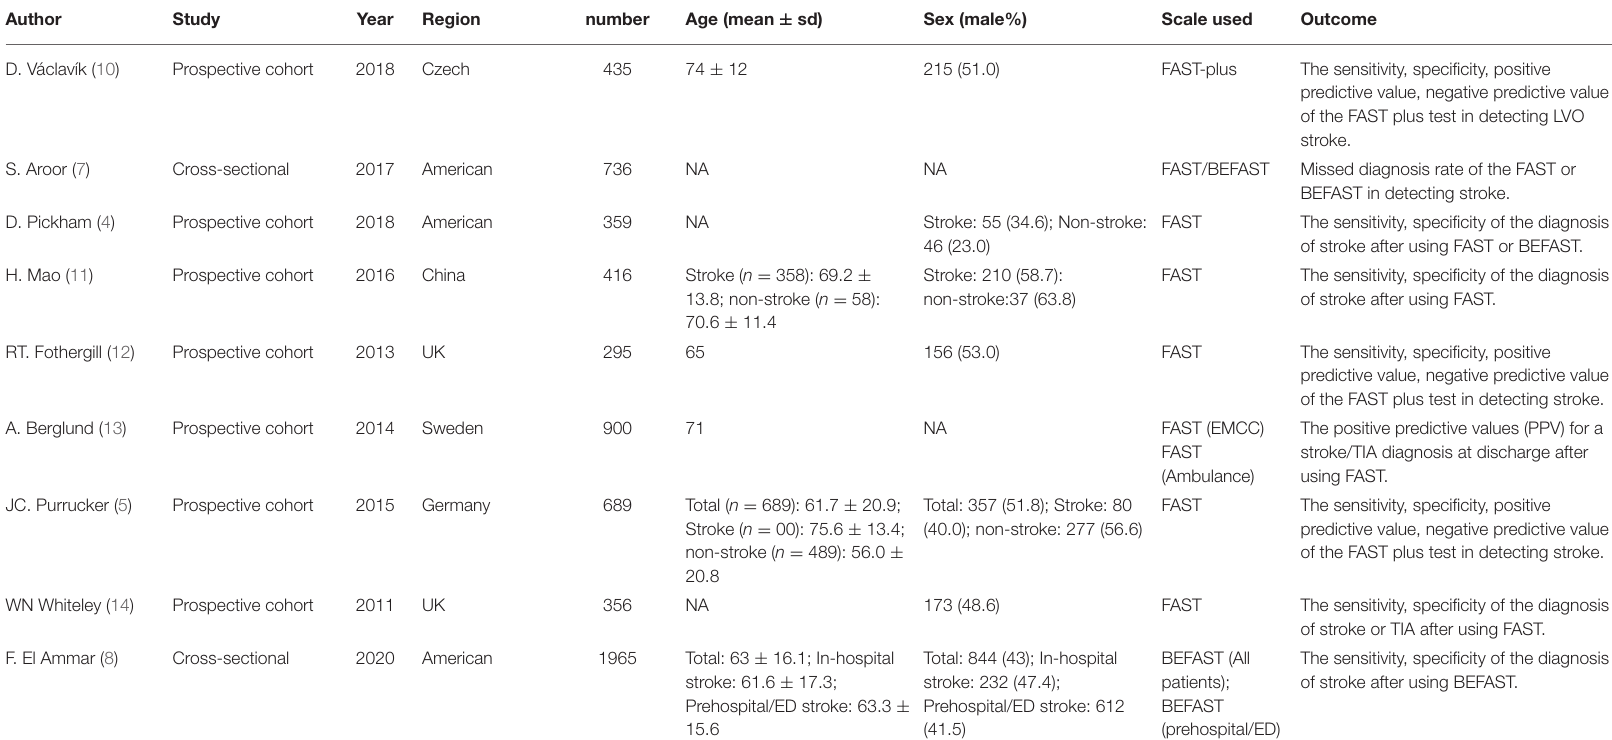
TABLE 1 | Basic characteristics of enrolled